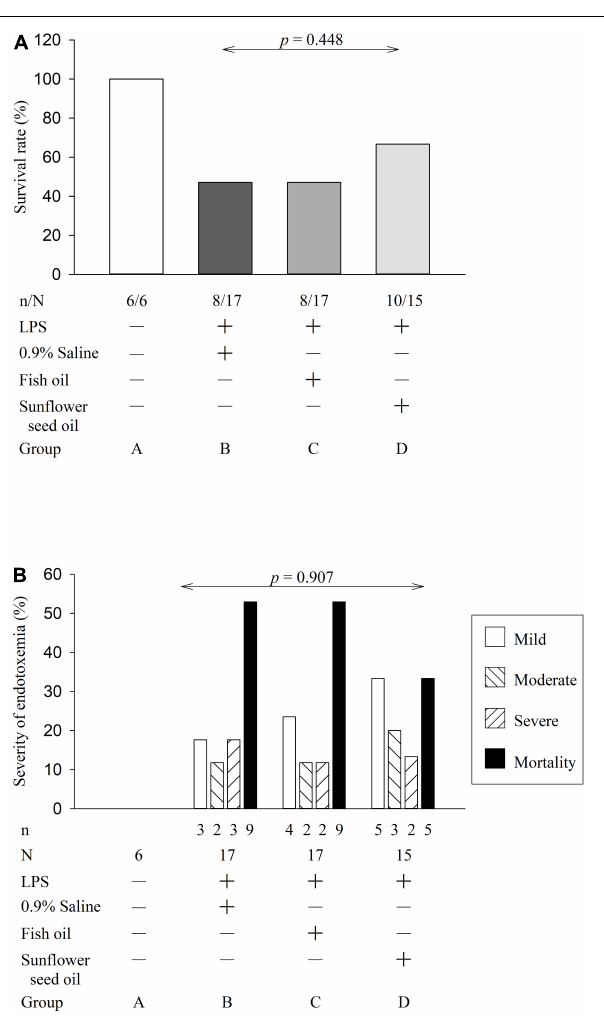
FIGURE 2 | Effects of dietary supplementation of fish oil and sunflower seed oil on survival rate (A) and severity of endotoxemia (B) . Data are expressed as a percentage (%). LPS, lipopolysaccharide; N, total number of rats of each group; n, number of rats that